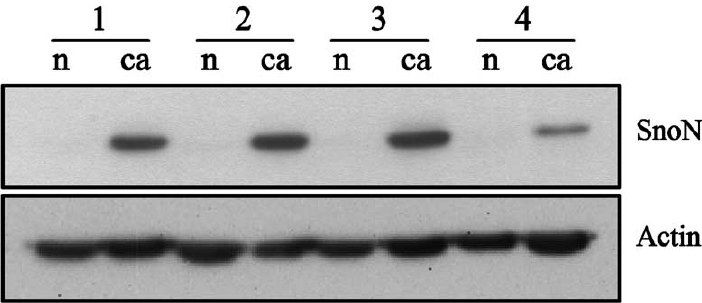
Fig. 3. SnoN expression by immunoblotting in four representative surgical specimens of human primary CRCs. Protein expression is absent in matched normal tissue. Actin antibody was used as a loading control. n – normal tissue, ca – neoplastic tissue. clear localization was detected in only 14 cases